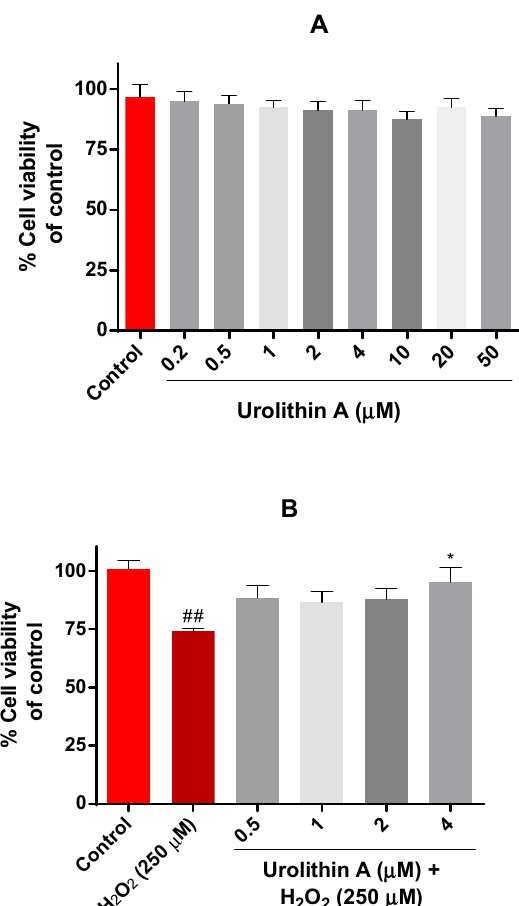
Figure 2. Mitochondrial activity in Neuro-2a cells culture (MTT assay). ( A ) Cytotoxicity of Neuro-2a cells after exposure to different concentrations of urolithin A. ( B ) Cytoprotective effects of urolithin A versus hydrogen peroxide (250 μ M). Note: * p < 0.05 versus H 2 O 2 ; ## p < 0.01 versus control.